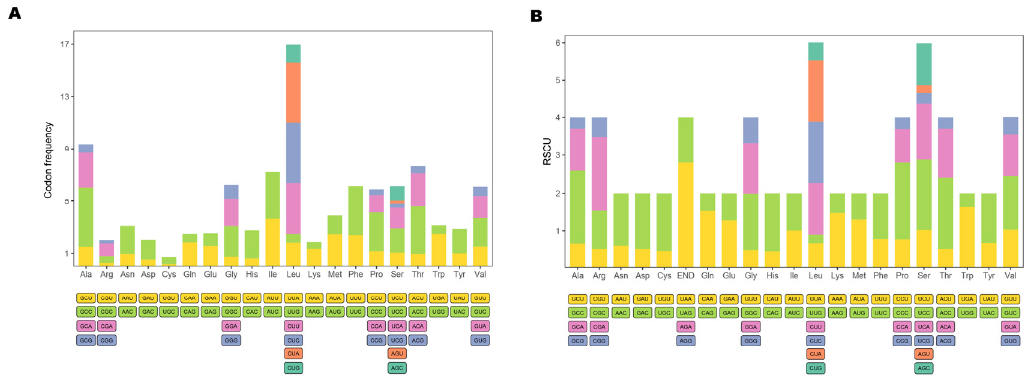
Figure 3. Codon usage frequency ( A ) and relative synonymous codon usage ( B ) in the P. dentex mitogenome. Amino acids are labelled on the x-axis and the codon families are displayed bellow.